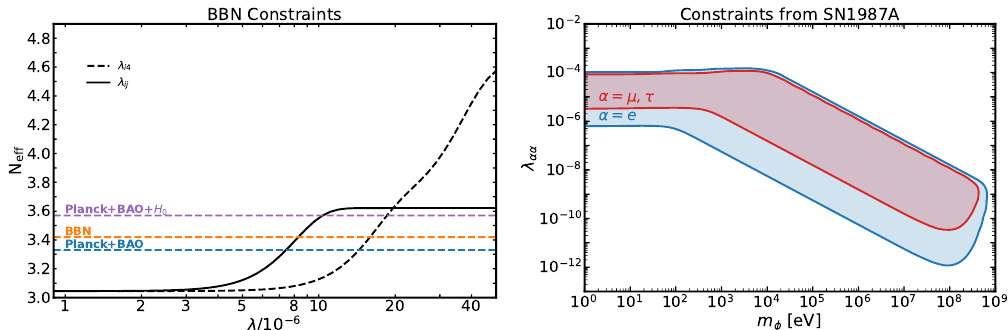
Figure 10 . Left panel: N eff constraints on neutrinophilic mediators. Both φ and ν 4 species are produced via the λ i 4 coupling. Via λ ij only φ can be produced. We have assummed m φ < 1 MeV. Right panel: constraints from the supernova SN198A observation. The constraint is given in the flavor basis as there are different chemical potentials involved for the three SM flavors. The translation to the mass basis via the PMNS matrix will only induce O (1) corrections, such that λ ij ’ λ ee